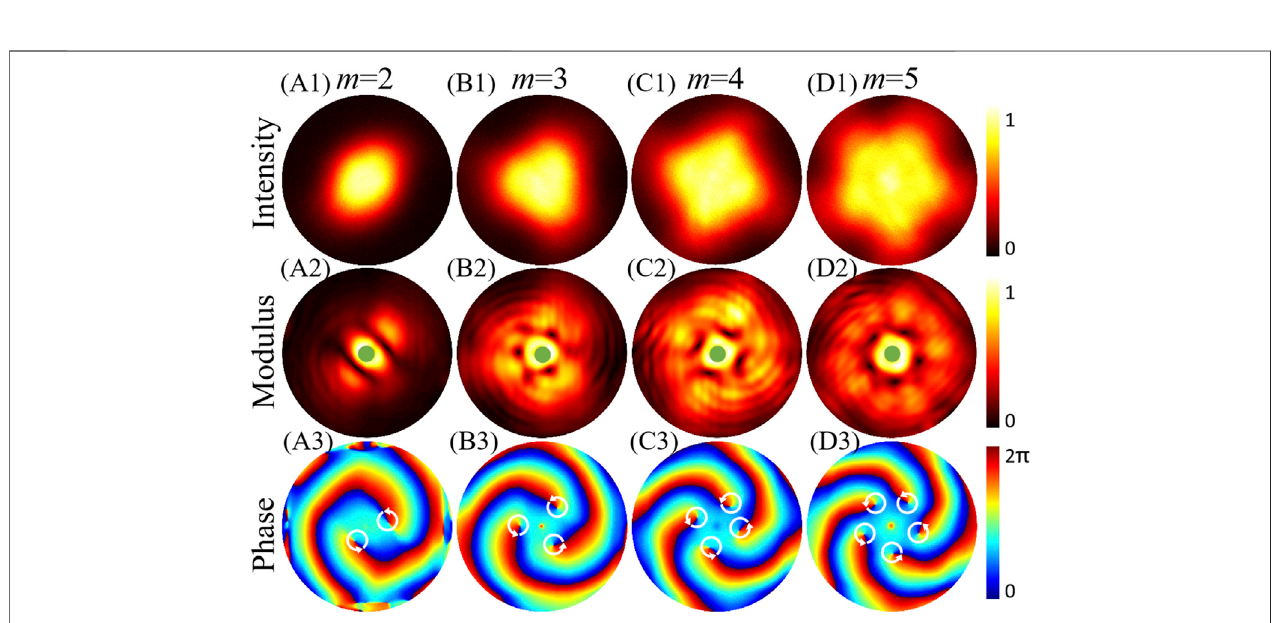
FIGURE 11 | Experimental intensity on CCD 1 and CSD distributions of the PC-PEPV beam with low spatial coherence width ( σ (cid:1) 0.5 mm). (A1 – D1) are intensity patterns, (A2 – D2) are modulus of the CSD function, and (A3-D3) are phase patterns of the CSD function.